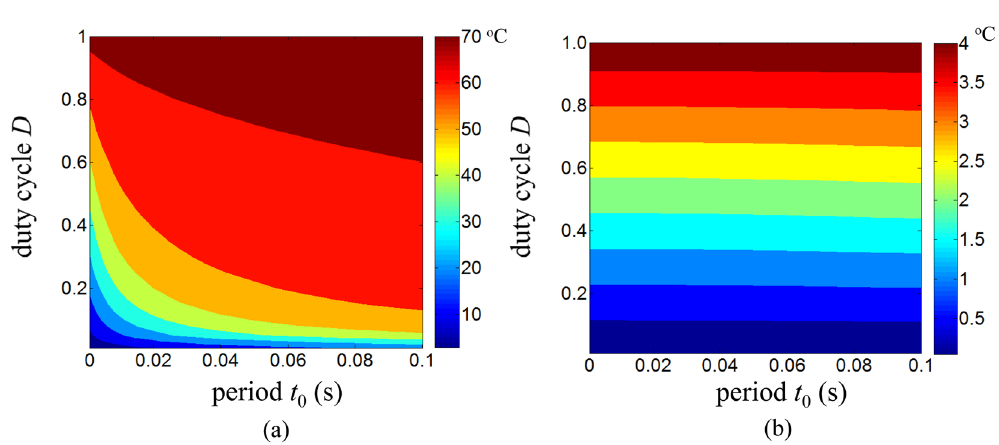
Figure 9. The effects of duty cycle and period on ( a ) the maximum μ -ILED temperature increase and ( b ) the maximum skin temperature increase under a pulsed